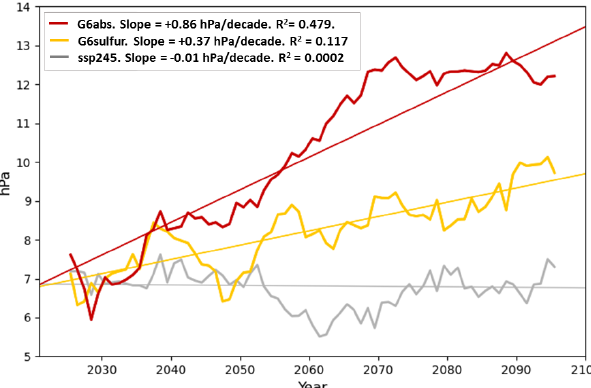
Figure 9. Evolution of the NAO, defined as the DJF mean sea- level pressure difference (hPa) between regions bounded by 90 ◦ W– 60 ◦ E, 20–55 ◦ N and 90 ◦ W–60 ◦ E, 55–90 ◦ N for each model in ex- periments SSP2–45 (ssp245 – grey), G6sulfur (yellow) and G6abs (red). All results are ensemble means and have been smoothed us- ing a 10-year running mean; a least-squares straight-line fit to each is also